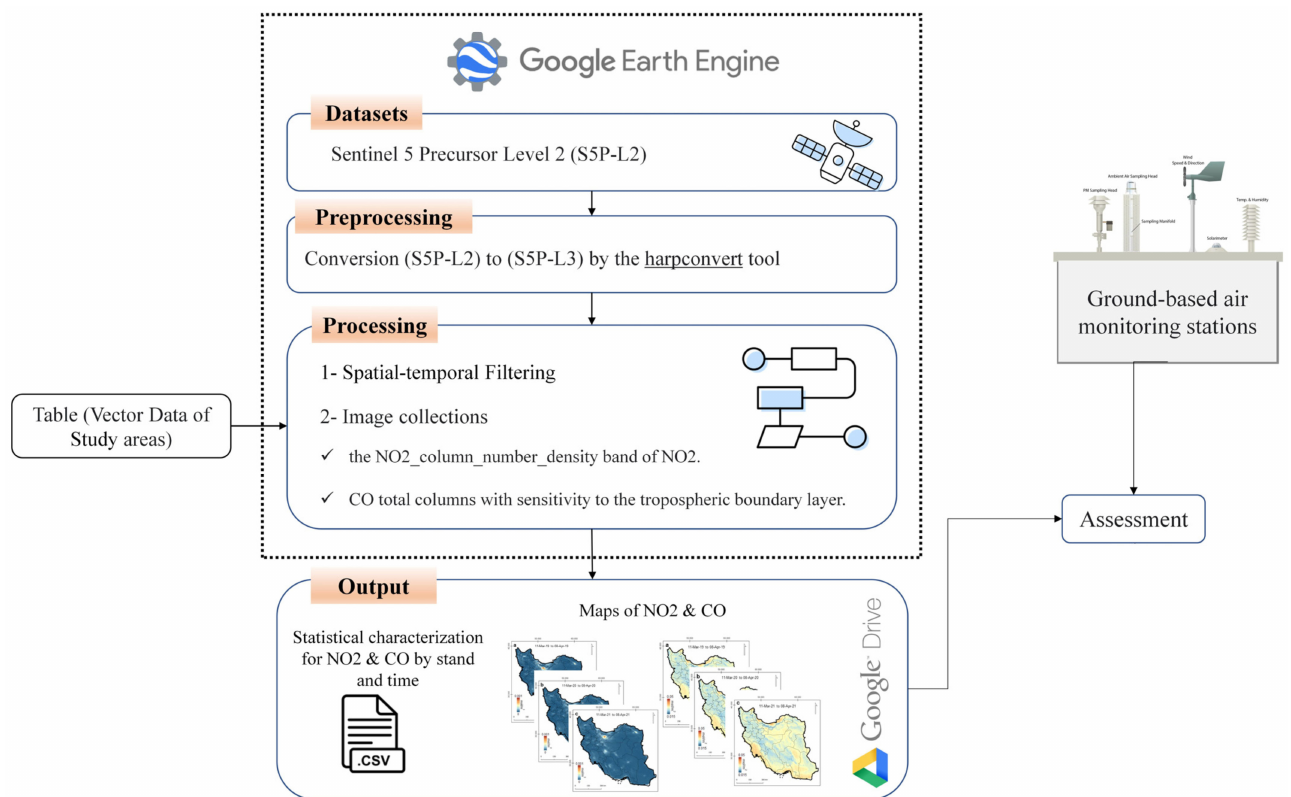
Figure 2. The process of producing air pollutants maps in the